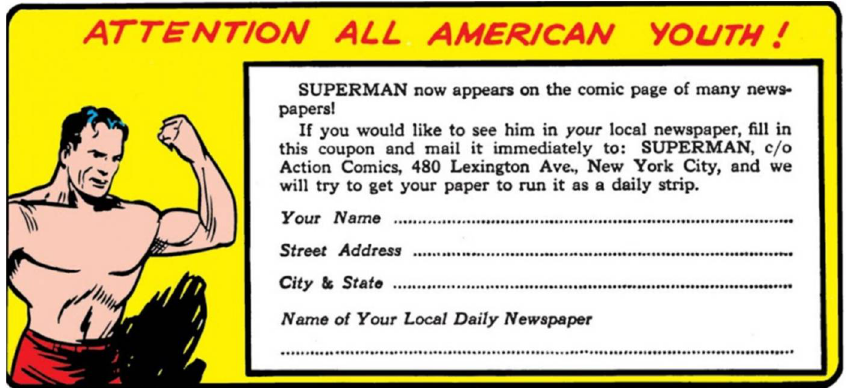
Figure 16. Joe Shuster, Closing Panel: “Attention all American Youth!” (panel No. 101), 1938. Siegel and Shuster (July 1938), “Superman”, Action Comics #2 (Siegel and Shuster 1938b, p. 34). © DC Comics.